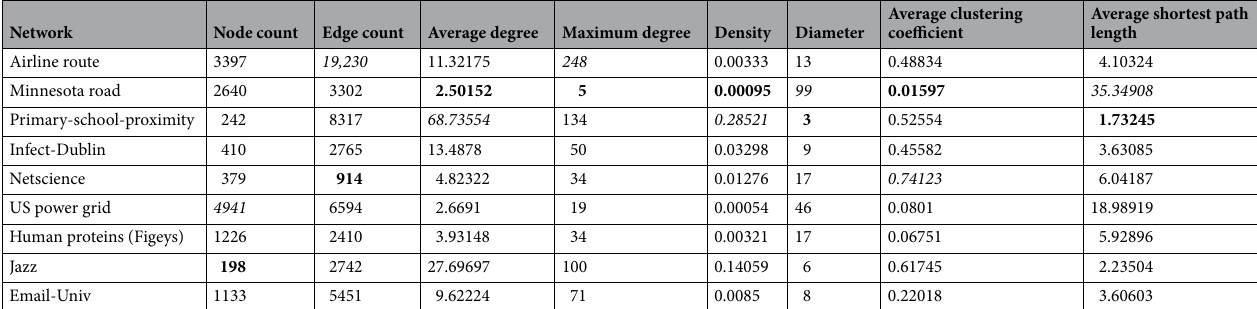
Table 3. Utilized datasets to test the efficiency of RLP in epidemics containment. Minimum value for each property, column, has been bolded, and maximum value for each property has been italics .